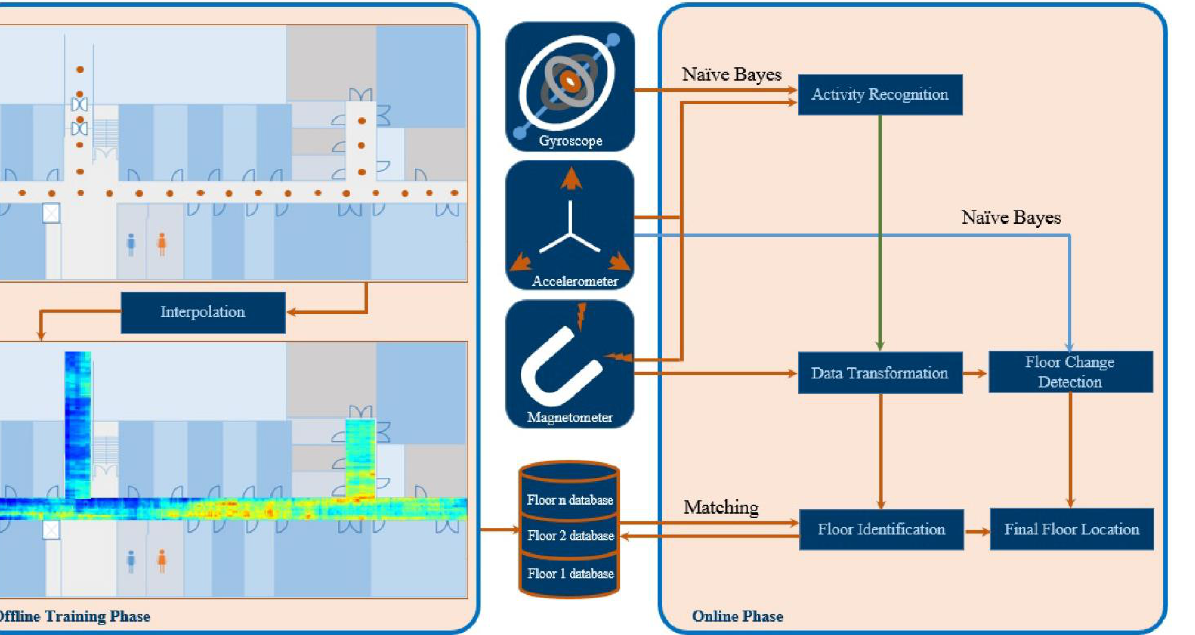
Figure 6. A three-step model for Floor Identification based on magnetic field data captured with smartphone sensors. (reproduced under the terms and conditions of the Creative Commons Attribution (CC BY) license from [5]).